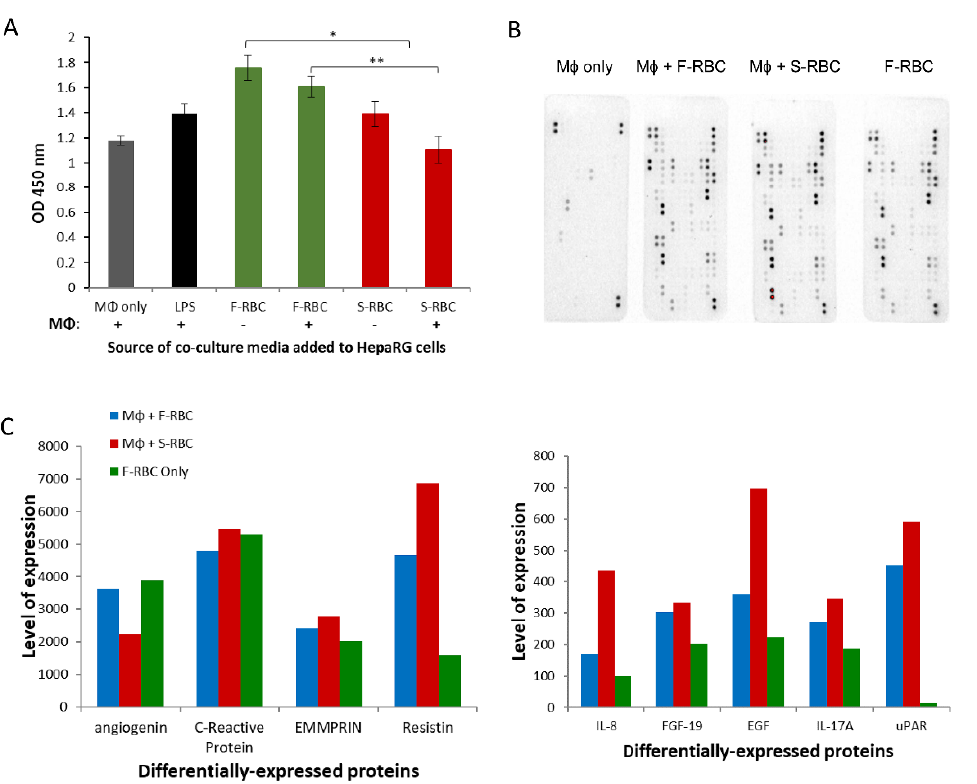
Figure 5. Conditioned media (CM) from macrophage-RBC co-cultures influences hepatocyte proliferation in-vitro. ( A ) HepaRG proliferation after addition of CM from F-RBCs or S-RBCs co-cultured in the presence (+) or absence ( − ) of macrophages (M Φ ), macrophages alone, and macrophages activated with LPS. ( B ) Images of Proteome Profiler Antibody Array membranes corresponding to different CM collected. ( C ) Differentially expressed proteins in CM from macrophages + F-RBC co-culture, macrophages + S-RBC co-culture, and F-RBCs only. * p < 0.05, ** p < 0.01.